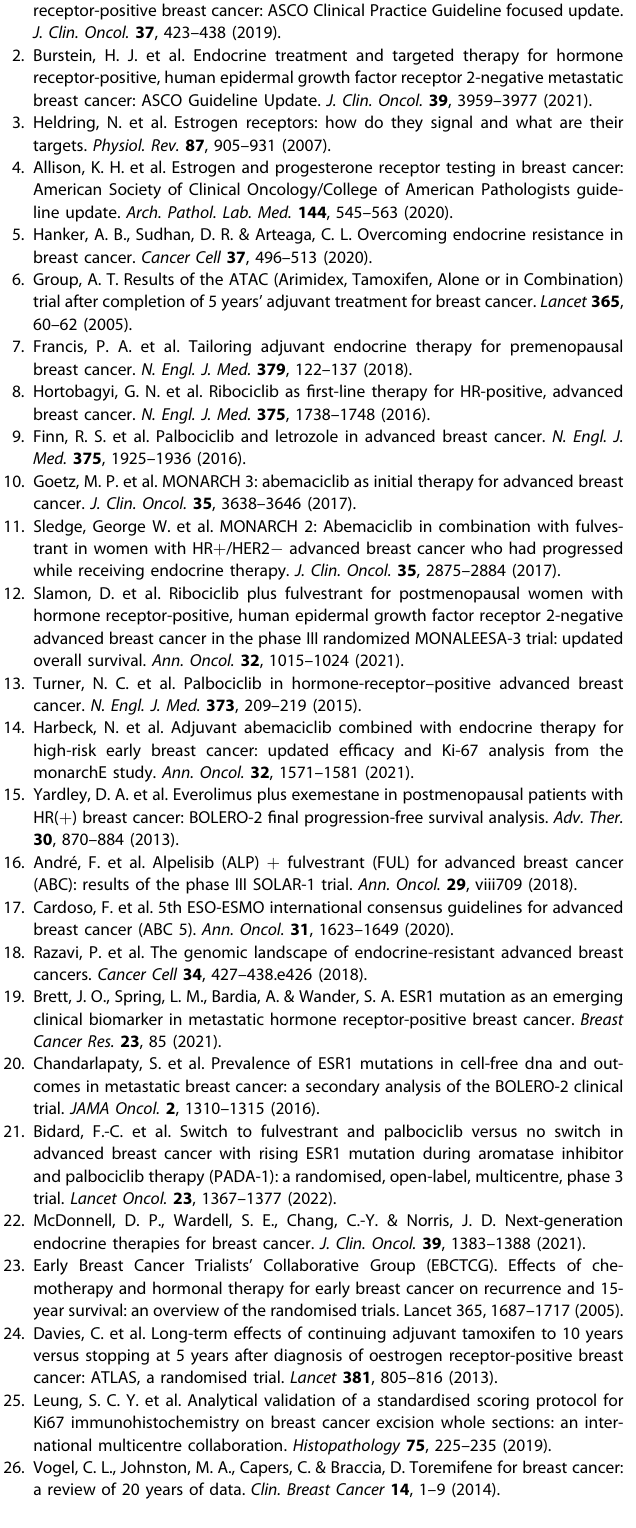
(Table 1). Phase 1b dose expansion and Phase 2 ef fi cacy evaluation are ongoing. Preliminary data in 40 subjects with a median of 3 prior lines of therapy demonstrated anti-tumor activity (ORR 9%, CBR 21%) and drug tolerability. In the cohort within the anticipated RP2D range, ORR was 18% (2/11), and CBR was 38% (3/8) (Table 2) 92